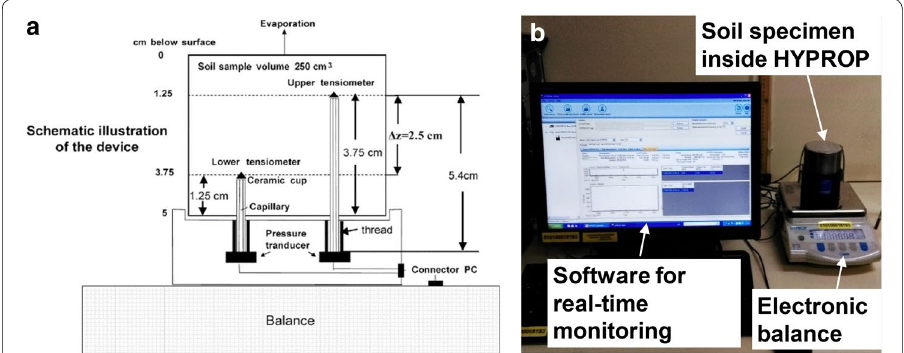
Fig. 5 a Schematic diagram of HYPROP and b Actual experiment setup of